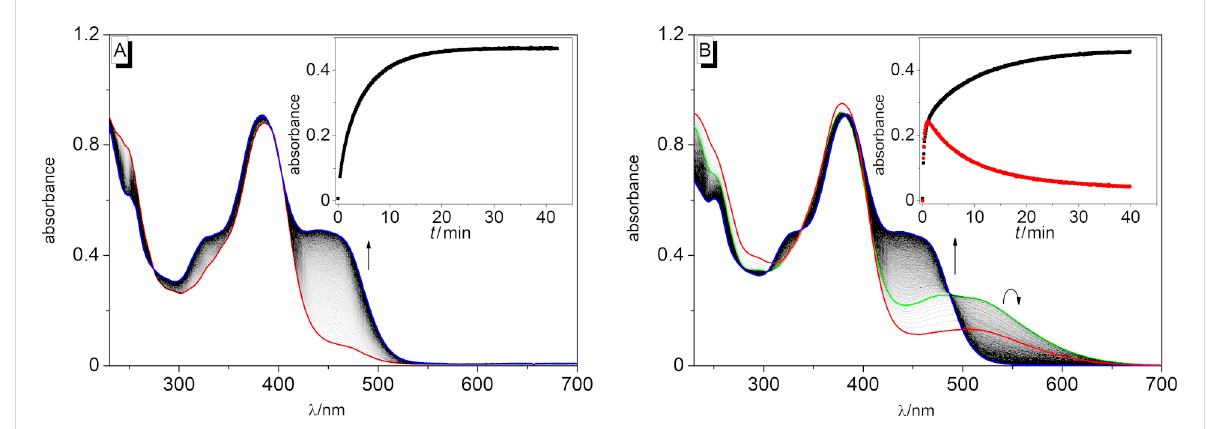
Figure 6: Spectral changes of 3a ( c = 20 µM) upon the addition of Cu 2+ (A) and Fe 3+ (B) ( c M+ = 60 µM) in MeCN. The arrows indicate the changes of the absorption during the reaction. Red: 25 s (A) or 10 s (B) after the addition, green: 60 s, blue: 40 min. Inset: Plot of the absorption at 463 nm (black) and 515 nm (red) vs the reaction time t